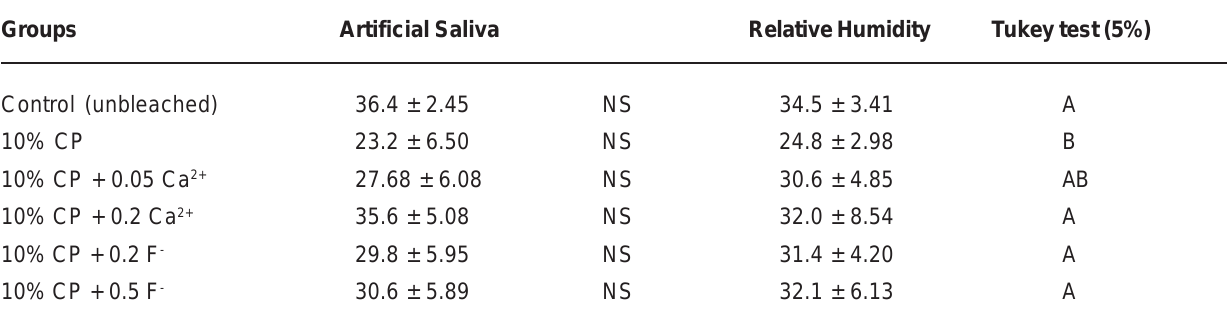
CP 10% - 10% Carbamide Peroxide. NS- no statistically significant difference between